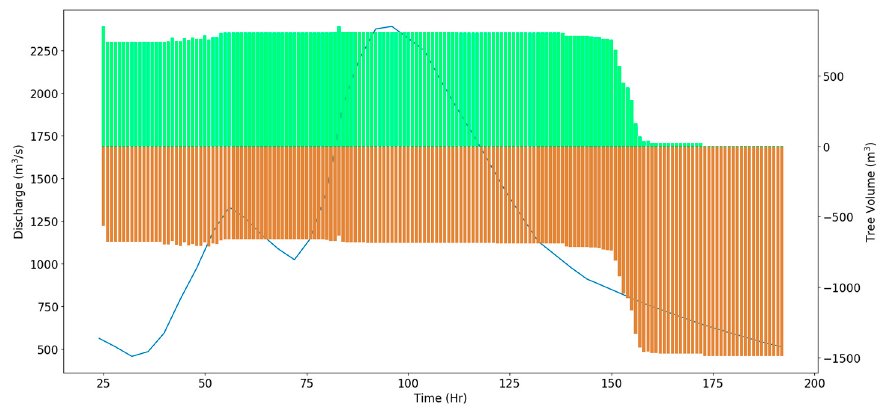
Figure 8. Temporal LWD transport dynamics against the hydrograph for the 50-year event.